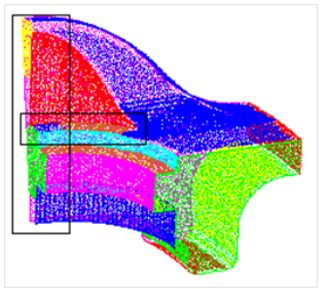
Figure 8. Over-segmentation in patch classification.